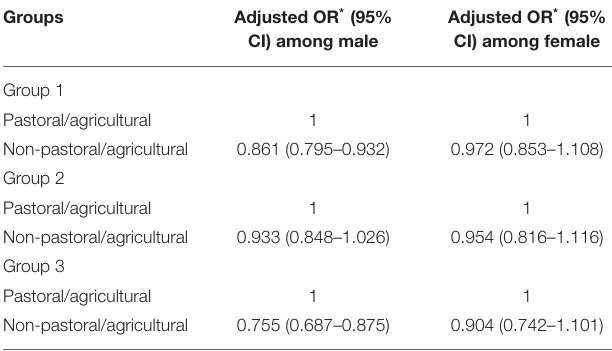
TABLE 6 | Stratified analysis by gender of association between area and diagnostic delays in human brucellosis.